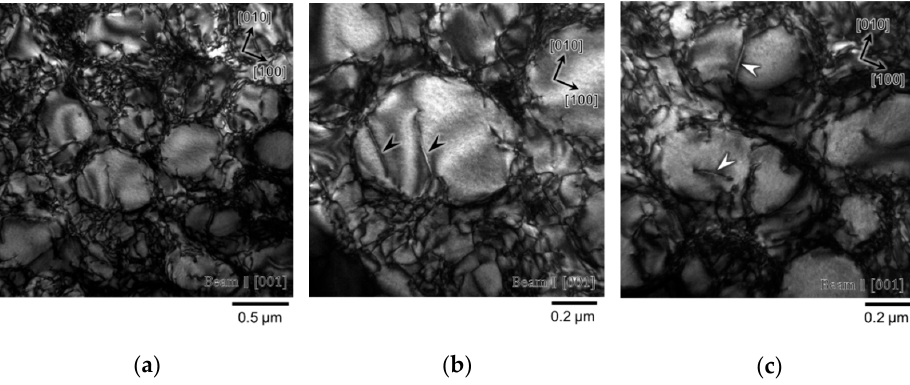
Figure 13. Bright-field images in the 50-h interrupted specimen using TEM from the view of the [001] zone axis. Black arrows indicate <110>-directed paired dislocations. White arrows indicate <100>-directed paired dislocations.